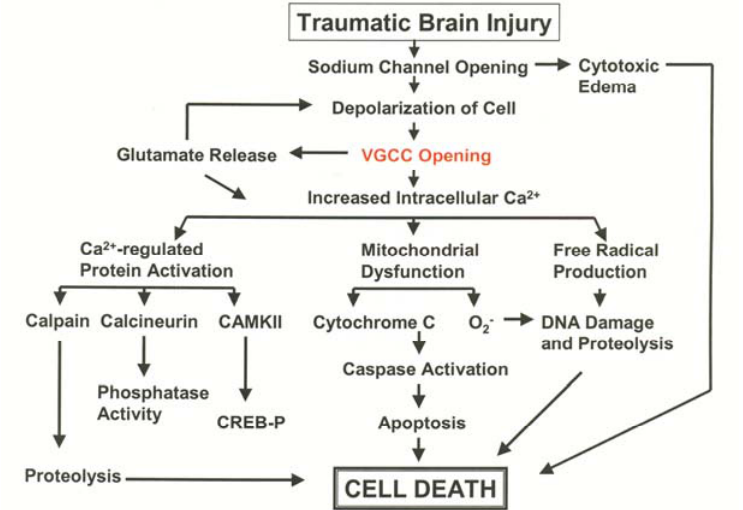
Figure 2. Schematic describing the role of VGCC in TBI-induced neuronal and astorcytic cell